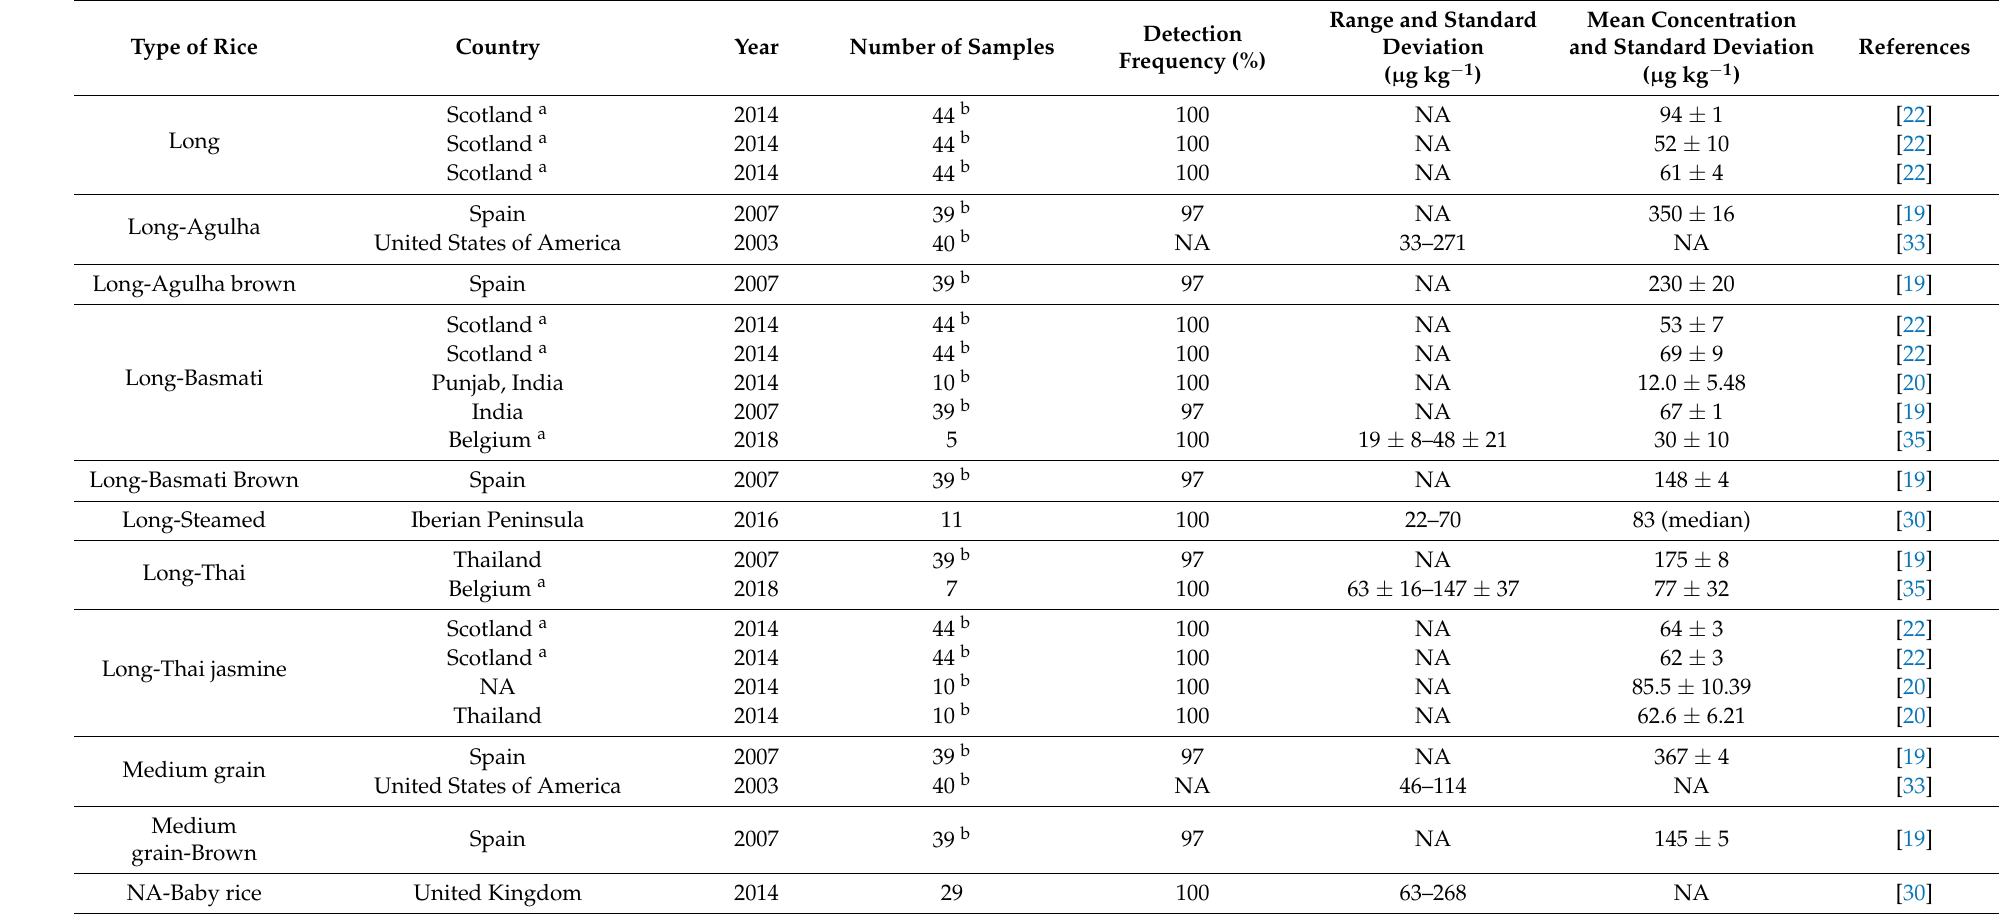
Table 2. Occurrence of arsenic in rice across the